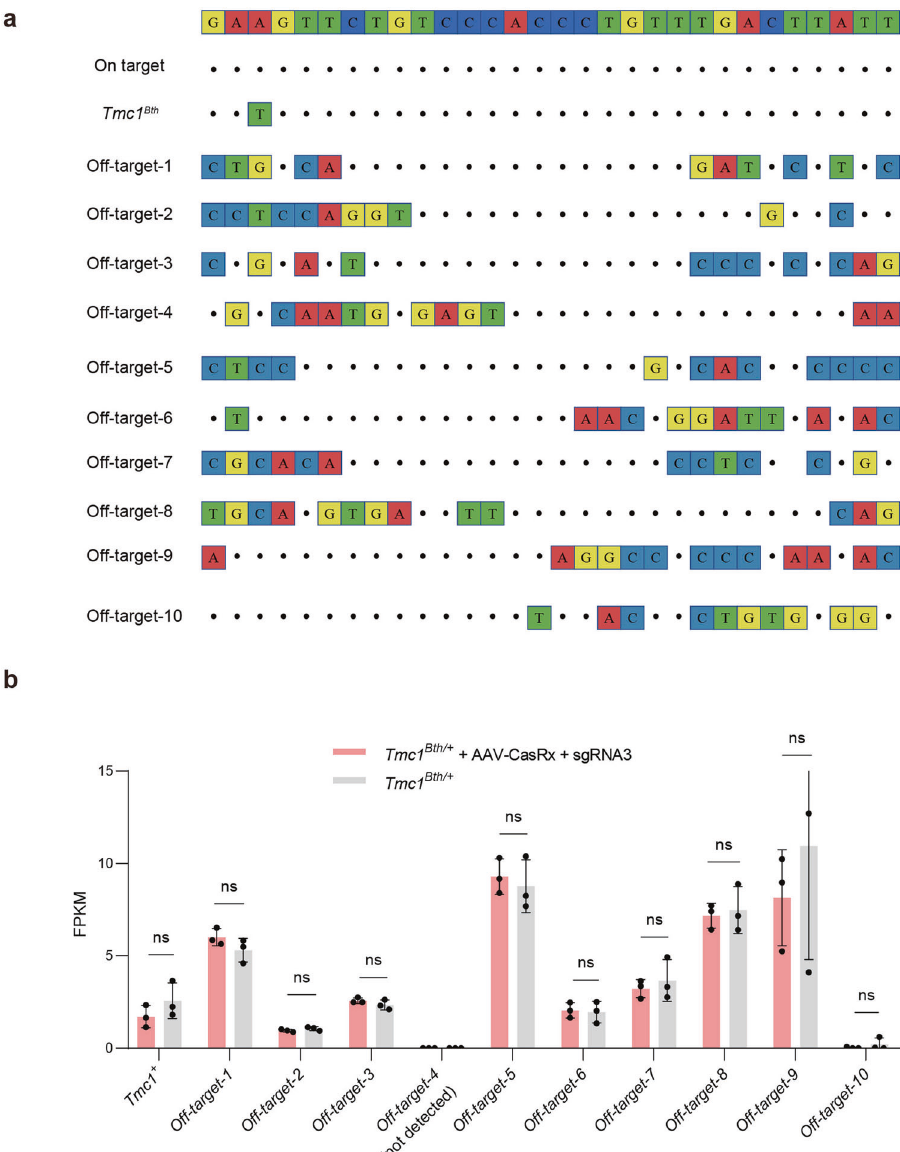
Fig. 6 Off-target analysis for RNA editing in vivo by RNA-Seq. a Off-target-1 to Off-target-10 were ten off-target sites detected by RNA-seq. Mismatches compared to the on-target site are shown and highlighted in color. The 30 bp sequence (On-target) targeted by the sgRNA3 is shown in the top row. b Comparison of FPKM values of the ten off-target sites at injected AAV-CasRx + sgRNA3 or non-injected ears. Data are shown as the mean ± SD. ns no signi fi cance. Statistical analysis was performed by multiple unpaired t